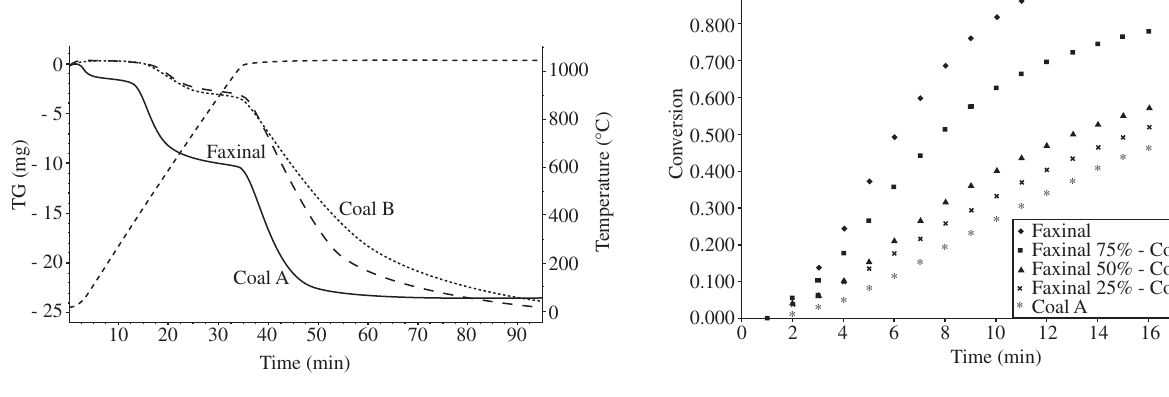
Figure �. Thermogravimetric analysis for Faxinal coal, coals A and B. Figure 3. Conversion up to 20 minutes isotherm for Faxinal coal, coal A and their